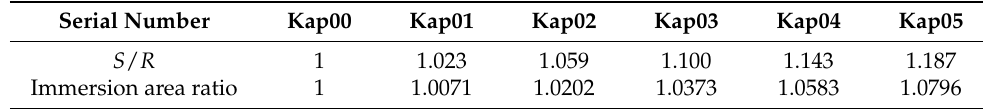
Table 1. Distinguished ratios of the Kappel propellers.